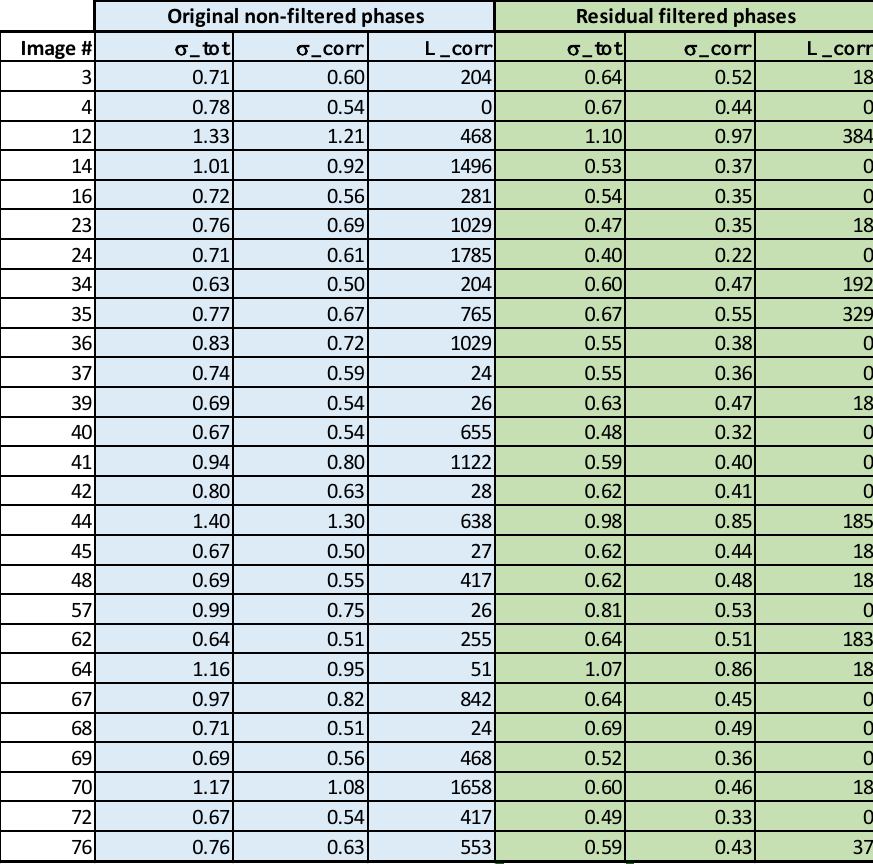
Table 1. Characterization of a set of phase images: original non-filtered phases versus the residual filtered phases